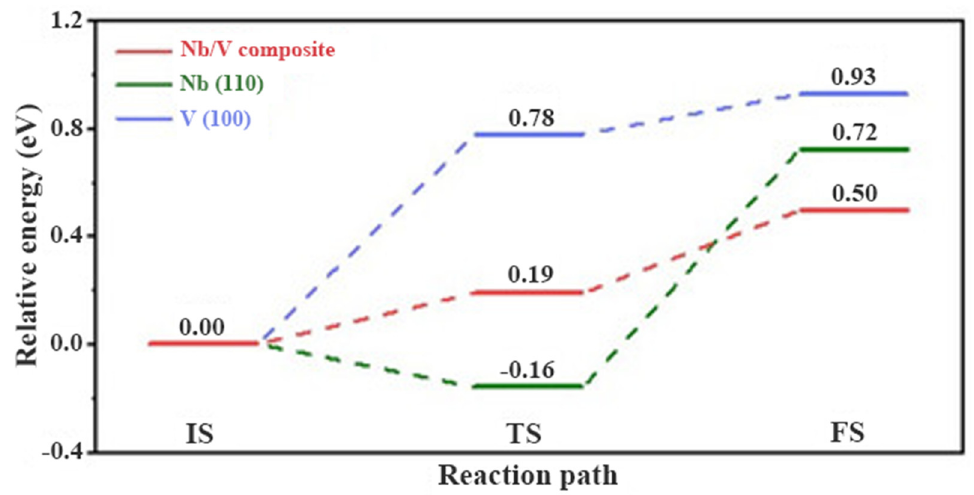
Figure 13. Calculated energy profiles for the H 2 desorption of MgH 2 on V (100), Nb (110) and Nb/V composites, respectively. Copyright 2022, Wiley Online Library. Reproduced with permission from [127].